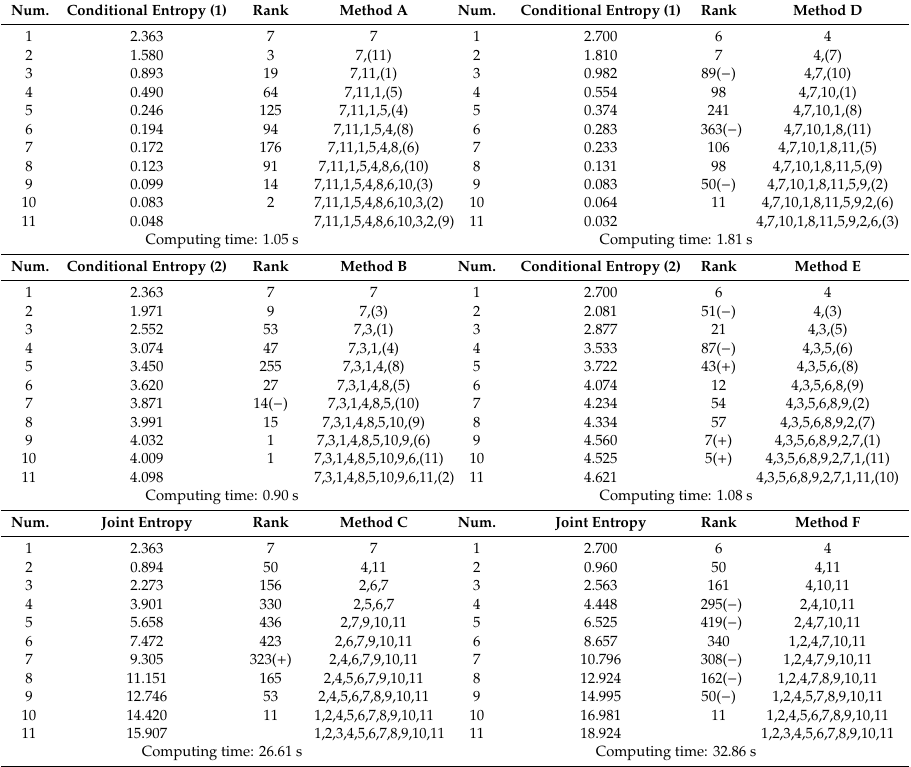
Table A6. Results of a select optimal rain gauge network of methods (weight: precipitation by 1-station). Num. ConditionalEntropy(1)